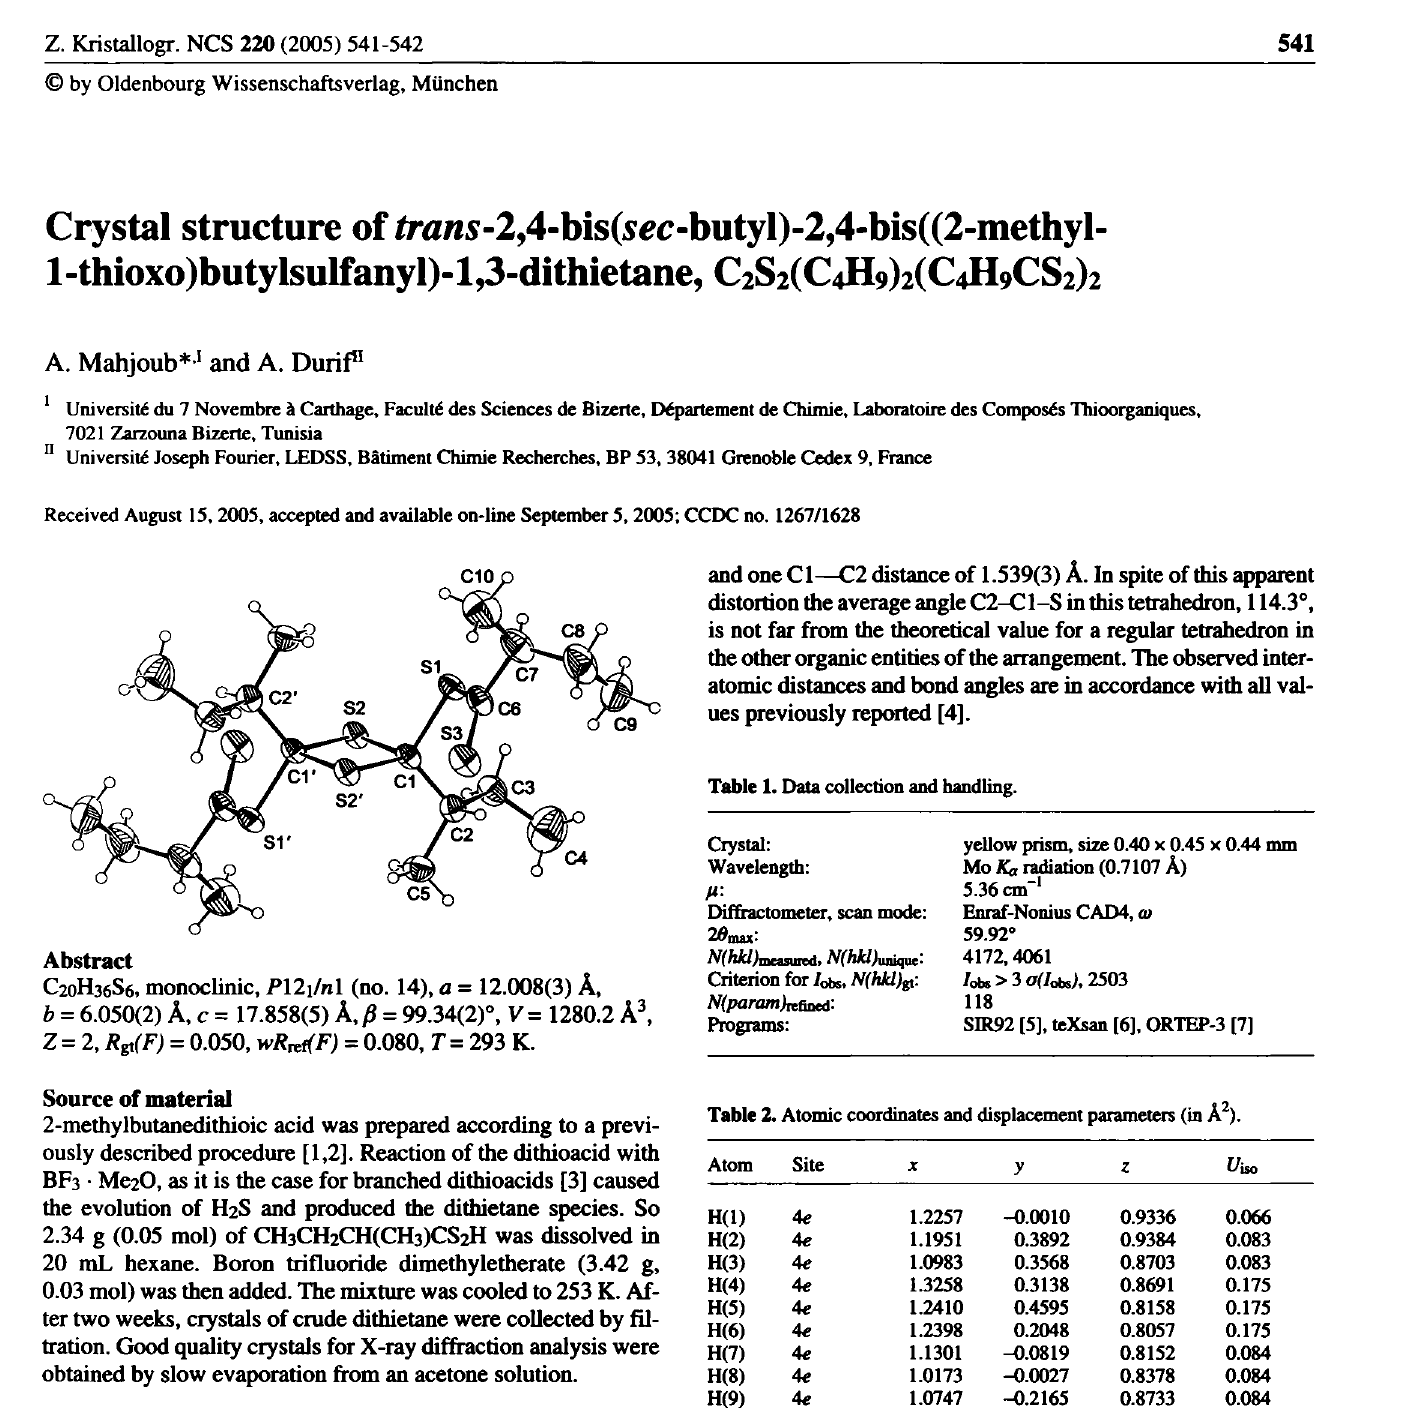
Table 2. Atomic coordinates and displacement parameters (in Ä 2